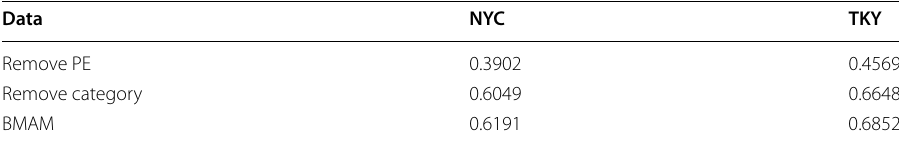
Table 3 Ablation analysis (Recall@5) on two datasets Data NYC TKY Remove PE 0.3902 0.4569 Remove category 0.6049 0.6648 BMAM